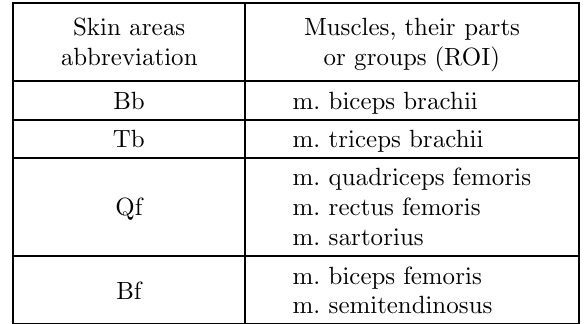
Table 2. Skin areas of selected muscles, their parts or groups (regions of interest =